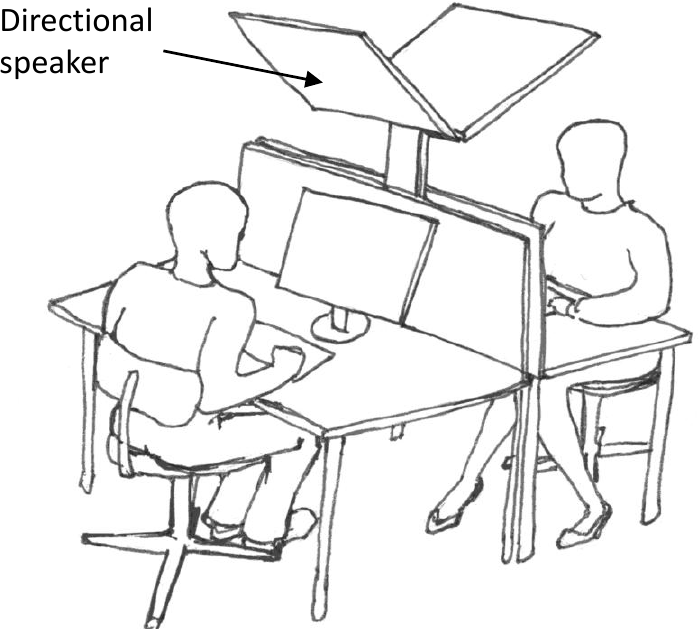
Figure 11. Conceptual drawing of creating individual audio environments at offices using directional